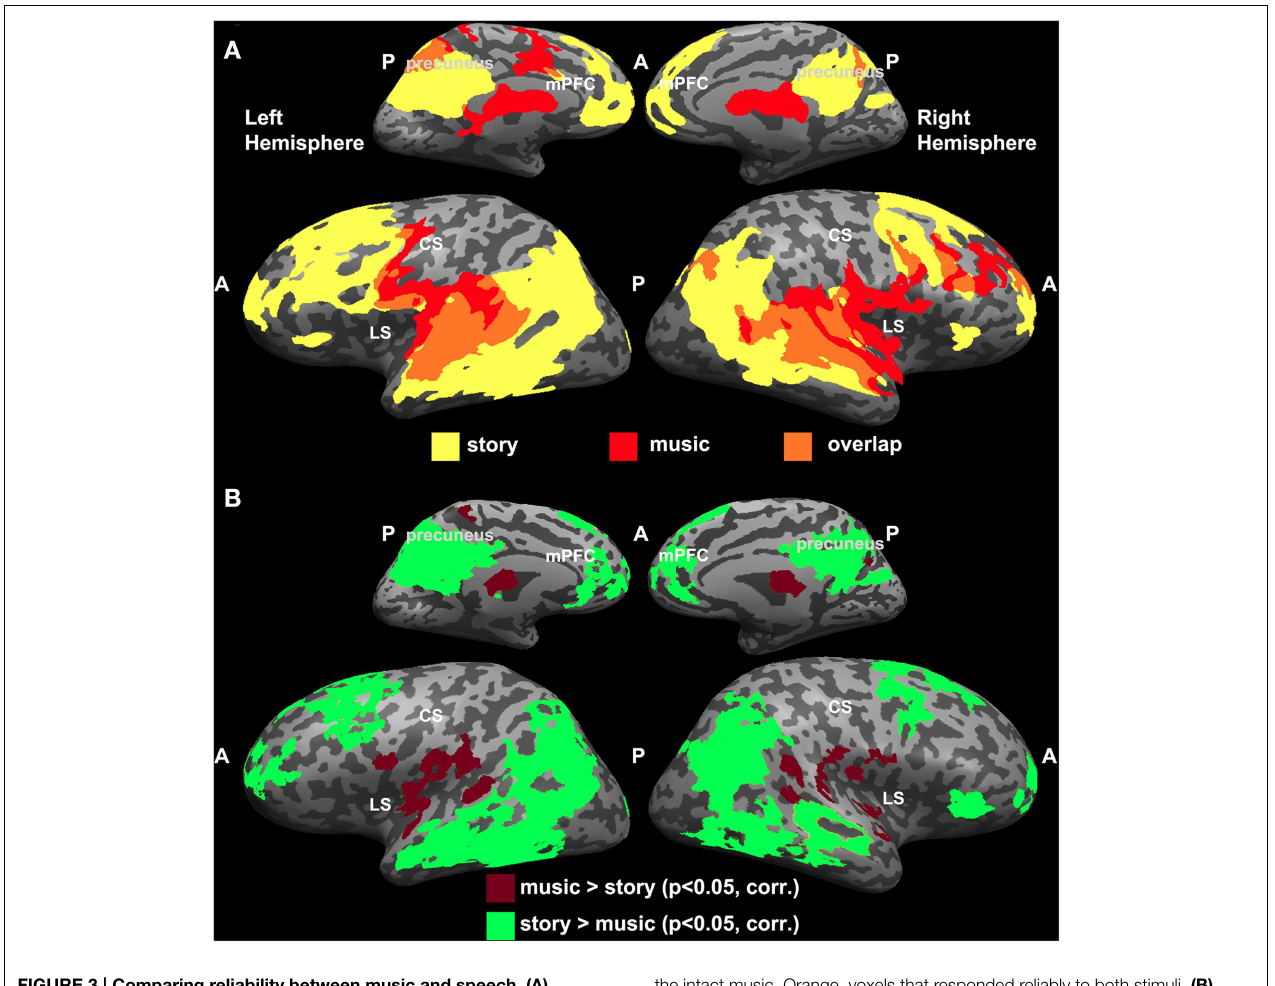
FIGURE 3 | Comparing reliability between music and speech. (A) Maps of inter-SC for intact story and intact music. Yellow, voxels that responded reliably to the intact story. Red, voxels that responded reliably to